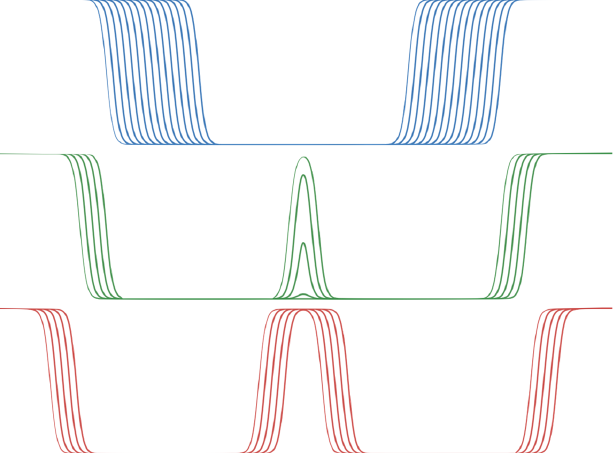
Figure 1. Functional form of C double (z) illustrating the membrane profile for three regimes of m. High values schematize the aqueous solvent, low values the membrane core. In blue, profiles ∀ m ∈ [0, 13.5]. In green, profiles ∀ m ∈ [13.5, 18]. In red, profiles ∀ m > 18.